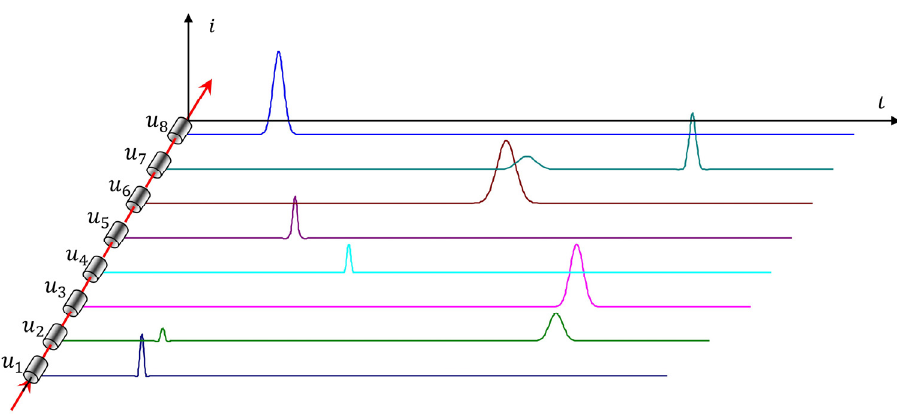
Figure 5. Diagram illustrating the technology of obtaining 3D HPLS chromatograms [20] using a multi-electrode array electrochemical detector. A chronoamperometry technique is used. Each of the eight working electrodes has a given potential (u 1 –u 8 ).